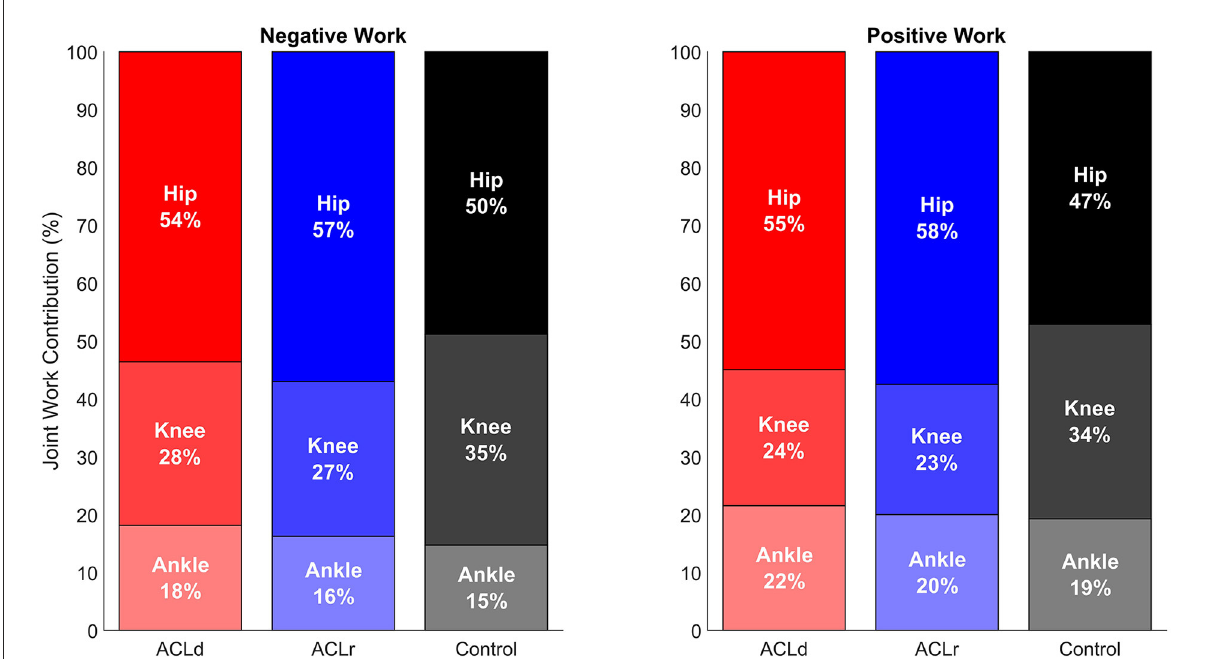
FIGURE5 Joint contributions to the lower limb work performed during the forward lunge. The patients with an ACL injury had a statistically significantly lower knee joint contribution on both negative (eccentric) and positive (concentric) work performed compared to healthy controls both pre and post ACL reconstruction. The patients compensated by increasing the contribution of the hip joint which reached a statistically significant difference compared to healthy controls post ACL reconstruction. For details of the statistical comparison between the groups refer to Table 3.